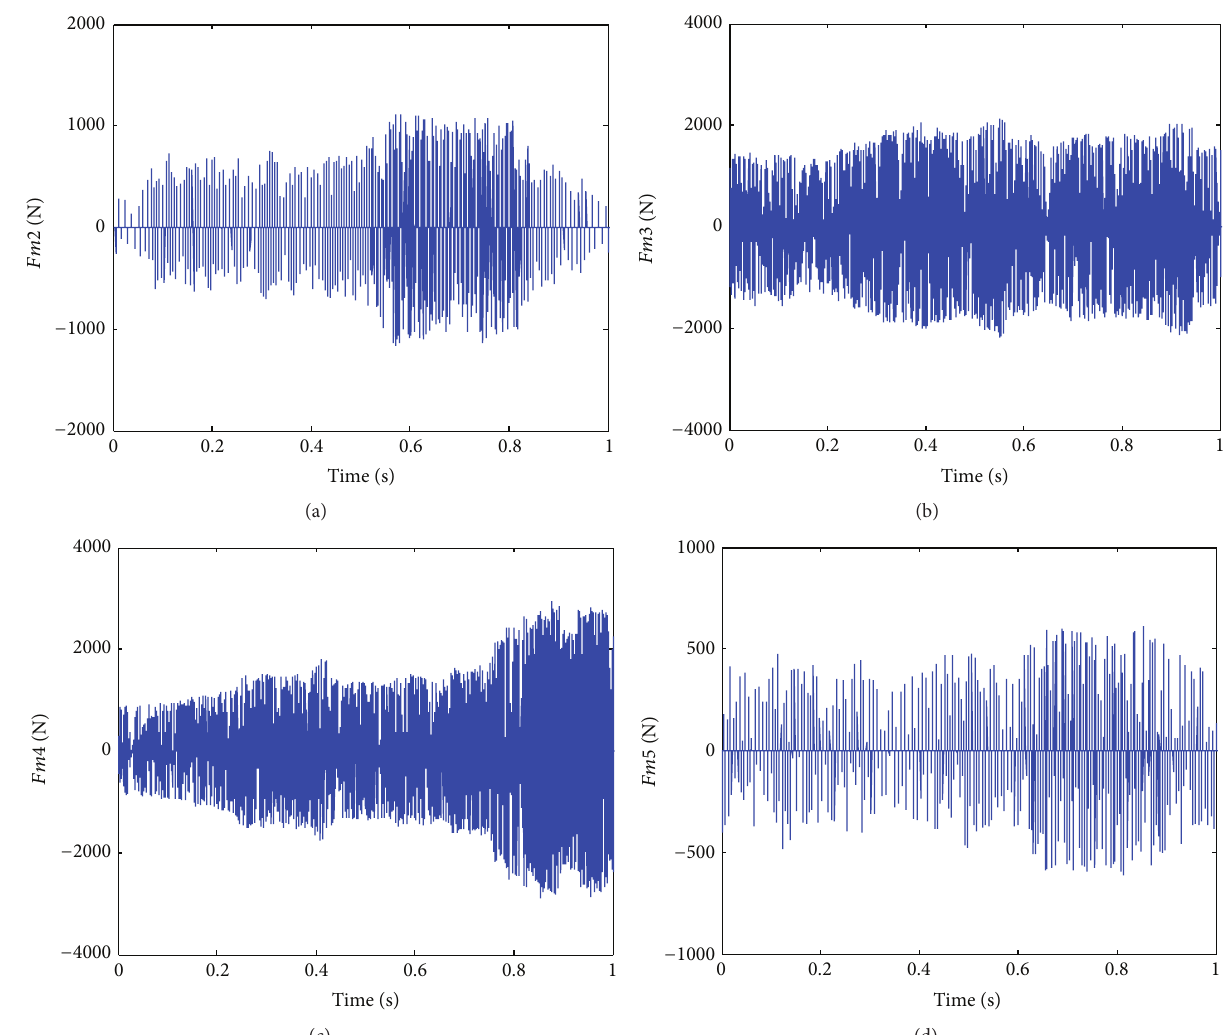
Figure 30: Rattle force of all unloaded gear pairs: (a) the 2nd gear pair, (b) the 3rd gear pair, (c) the 4th gear pair, and (d) the 5th gear pair.